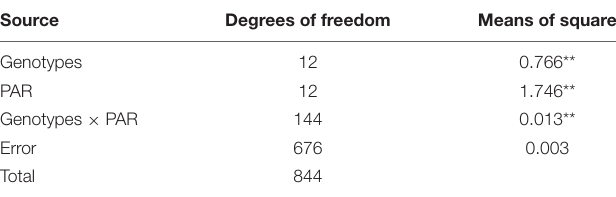
TABLE 9 | Analysis of variance for electron transport rate.